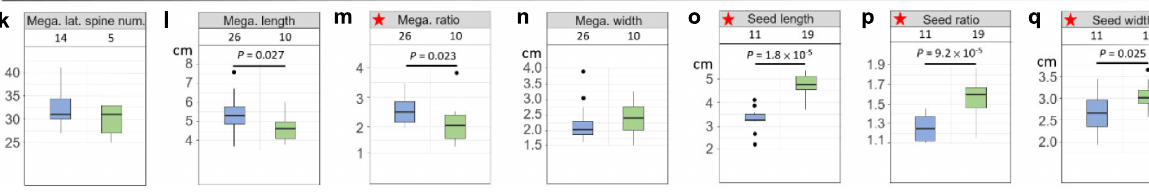
mean coverage was 59.8 × (minimum = 28.3 × ). The population program kept 2,055 loci with a mean length of 238.21